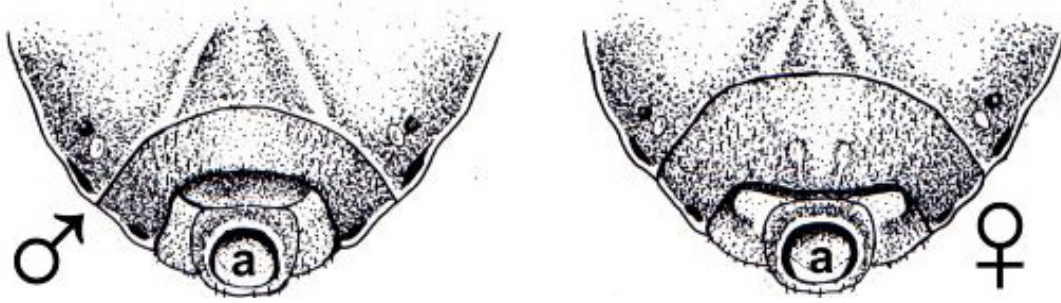
Figure 1. Line drawings illustrating the immature genitalia in L5 of Rhodnius prolixus . microscope the two concentric genital segments immediately around the anus (a) are examined. In the male (left diagram), the segment encircling the anus is entirely visible, not covered by the next anterior segment. Along its posterior edge, this next segment is approximately equidistant from the anus. In females (right side), the segment encircling the anus is partially covered at the midline by the next anterior segment, and there is little to no space between its middle posterior edge and the anus. Also, this segment in females often in the corresponding segment in